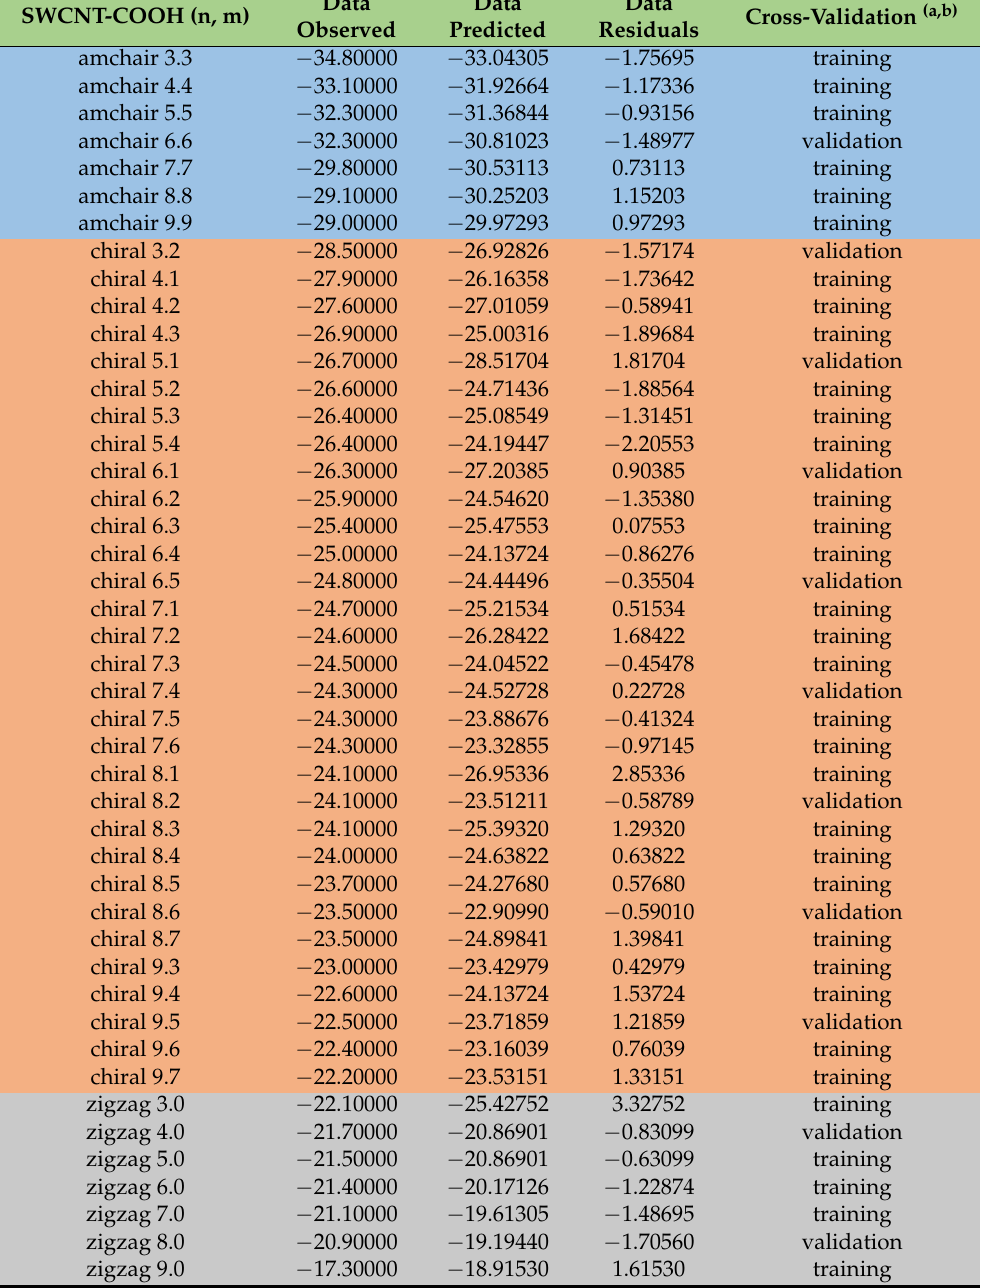
Table 3. Results of the Nano-QSTR regression model for mitochondrial F0-ATPase inhibition induced by SWCNT-COOH. SWCNT-COOH (n, m)